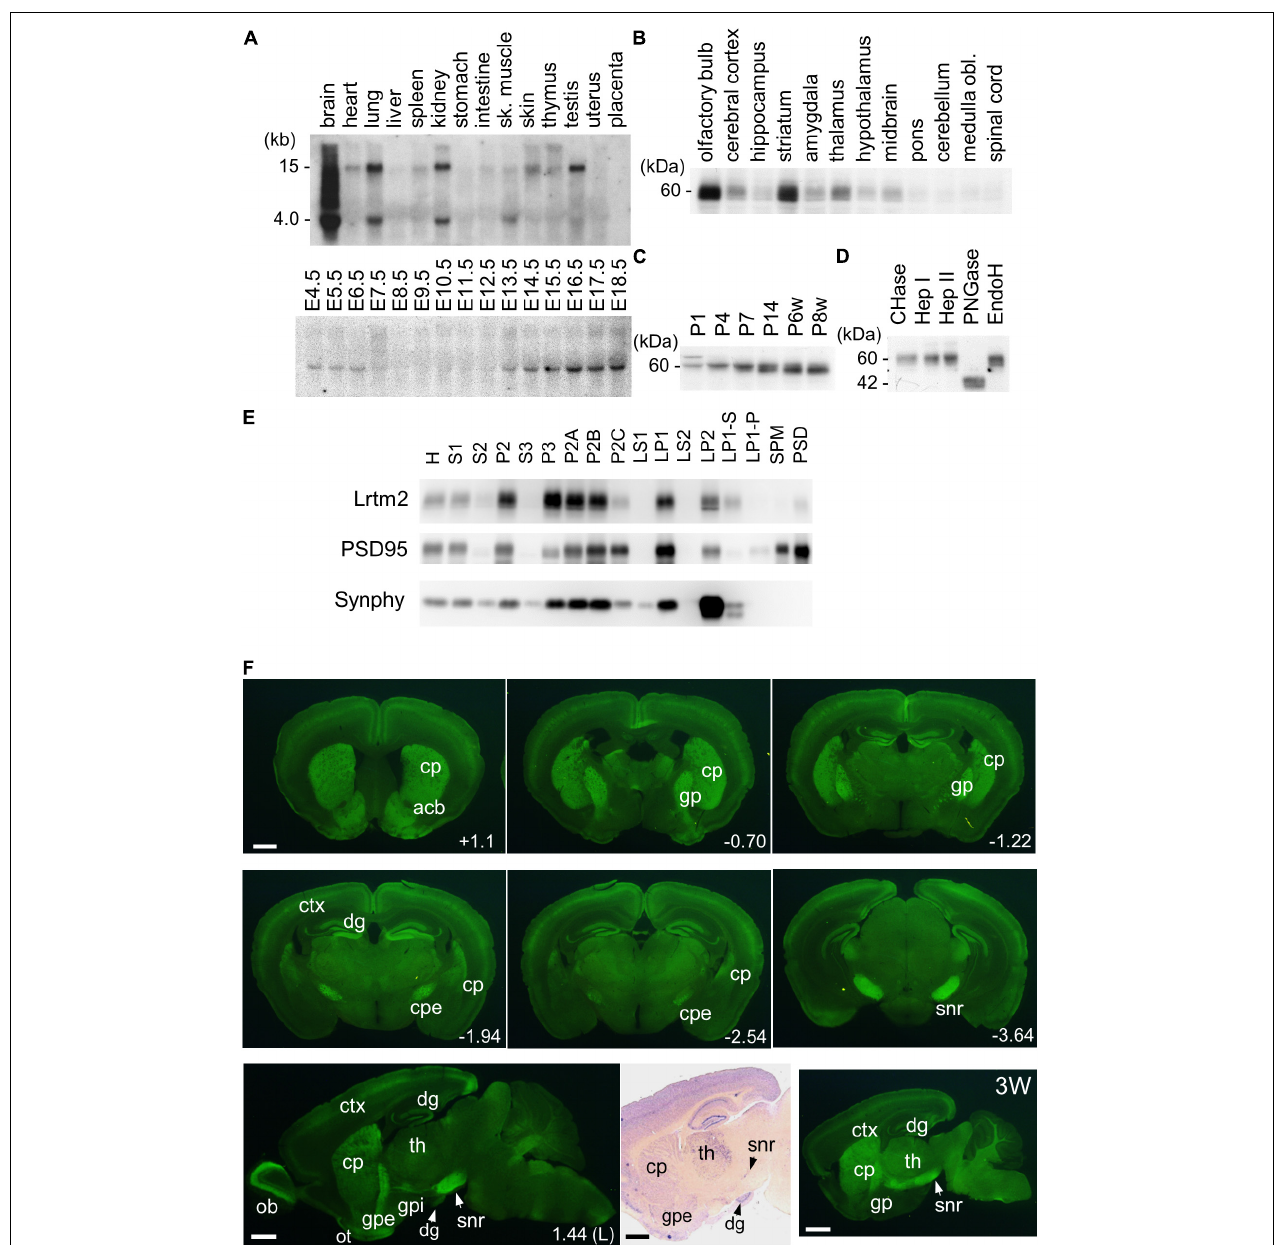
FIGURE 3 | Expression of Lrtm2 and distribution of Lrtm2 protein. (A) Northern blot analysis. Top , organ blot. Bottom , temporal expression profile during embryonic development. sk, skeletal; E, embryonic day. (B–E) Immunoblot analysis. (B) Regional distribution of Lrtm2 in the brain. (C) Lrtm2 abundance in the brain during postnatal development. P, postnatal day or week (w). (D) Glycosidase sensitivity of Lrtm2 protein. Only peptide N-glycosidase F (PNGase) resulted in a band shift to a lower molecular weight range, indicating that Lrtm2 is an N-glycosylated protein. CHase, chondroitinase ABC; Hep I, heparinase I; Hep II, heparinase II; EndoH, endoglycosidase H. (E) Subcellular distribution. H, homogenates; S1, postnuclear supernatant; S2, supernatant after P2 precipitation; P2, crude synaptosome; S3, cytosol; P3, light membrane; P2A, myelin-enriched fraction; P2B, synaptosome-enriched fraction; P2C, mitochoindria-enriched fraction; LS1, supernatant after LP1 precipitation; LP1, crude synaptosomal membranes; LS2, supernatant after LP2 precipitation; LP2, synaptic vesicle-enriched fraction; LP1-S, 1% Triton-X100-soluble LP1 fraction; LP1-P, 1% Triton-X100-insoluble LP1 fraction; SPM, synaptosomal plasma membranes; PSD, postsynaptic density fraction; PSD95, an excitatory postsynaptic protein; Synphy, synaptophysin, a presynaptic marker. (F) Immunostaining. 8-weeks-old or 3-weeks-old (3W) mouse brain sections are immunostained with an anti-Lrtm2 antibody. cp, caudoputamen; cpe, cerebral peduncle; ctx, cerebral cortex; dg, dentate gyrus of hippocampus; gp, globus pallidus; gpe, external segment of globus pallidus; gpi, internal segment of globus pallidus; ob, olfactory bulb; ot, olfactory tubercle; snr, substantia nigra pars reticulata; th, thalamus. Numerical values in the pictures indicate relative distance (mm) from Bregma or midsagittal plane (L) (Paxinos and Franklin, 2001). Bright field image , in situ hybridization showing Lrtm2 mRNA distribution in 1.44 (L) parasagittal section. Note the difference when compared with Lrtm2 protein (left adjacent image). Scale bar , 1 mm.